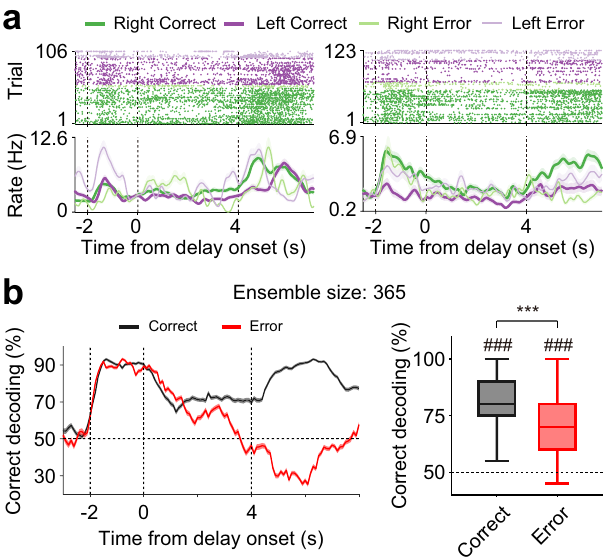
Fig. 4 Delay-period activity of untagged WS neurons during correct and error trials. a Example responses of untagged WS neurons ( n = 365 recorded in the sessions with ≥ 2 error trials for both targets) during correct and error trials. The same format as in Fig. 3a except that correct (saturated colors) as well as error (soft colors) trials are shown. b Left, neuronal population decoding of target using untagged WS neurons ( n = 365; 1-s window advanced in 0.1-s steps). Correct trials were used as training data, and both correct (black) and error (red) trials were used as test data. Right, neural decoding of target based on entire delay-period (4 s) activity. ### p < 0.001 (difference from chance level, t -test); *** p < 0.001 (correct versus error, paired t -test). Shading, SEM across trials ( a ) or 100 decoding iterations ( b , left). Boxplots ( b , right) show median, interquartile range, and maximum and minimum within 1.5 interquartile